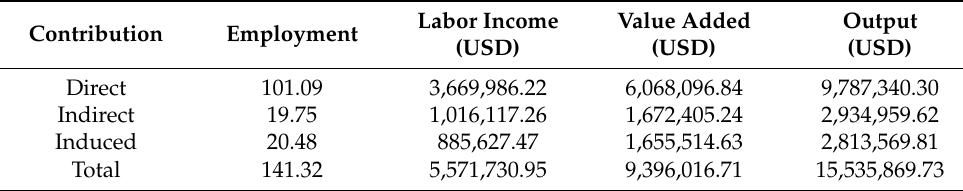
Table A12. Contribution of Partner Visitation to Lee and Collier Counties (Annual).